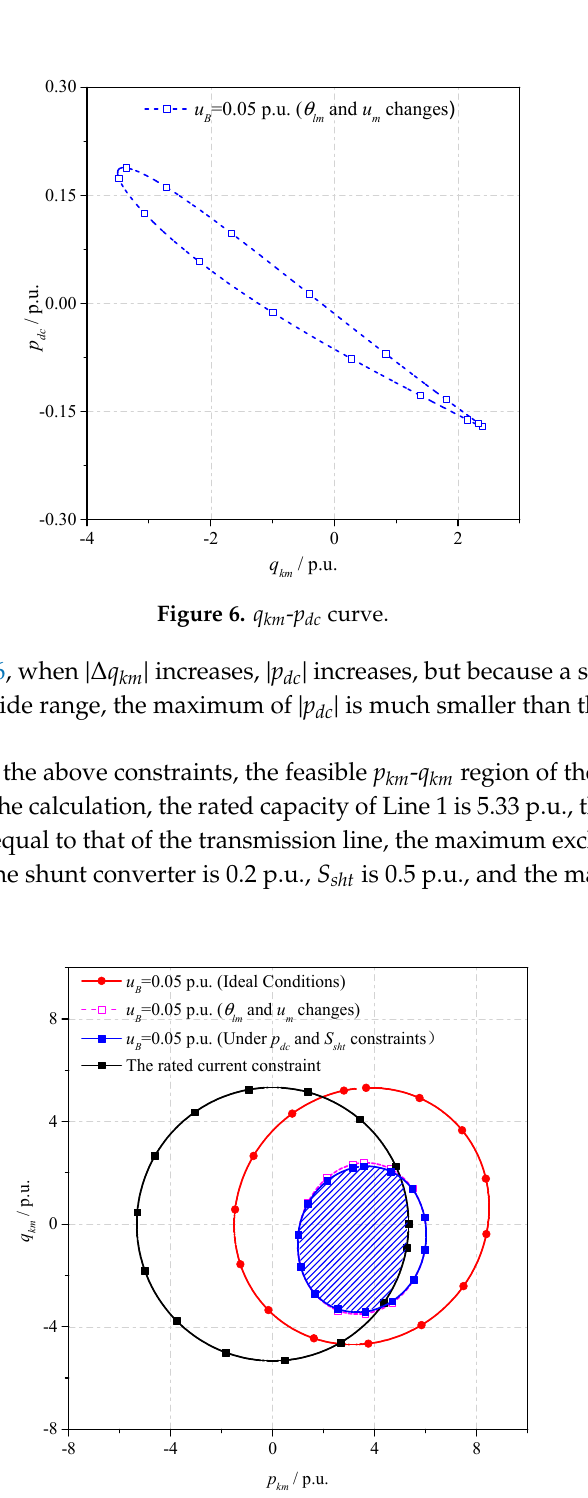
Figure 7. Schematic diagram of the feasible p km - q km region.